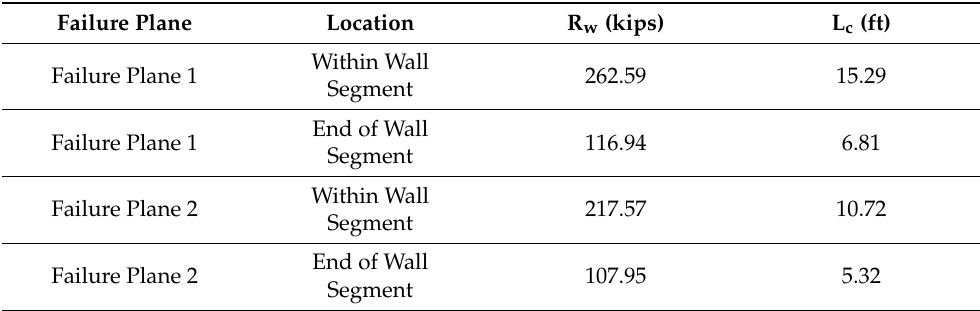
Table 1. Barrier Capacity from Yield Line